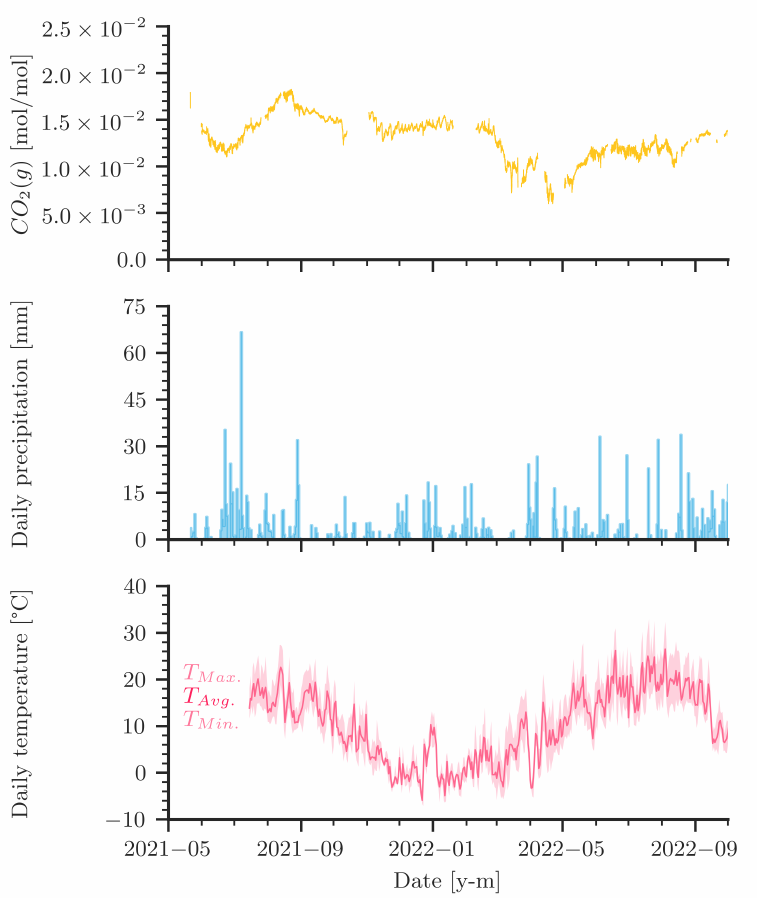
Figure 5. Measured gaseous CO 2 levels compared to precipitation and temperature during mea- surement campaign (May 2021 to October 2022). Daily precipitation data are obtained from DWD (Deutscher Wetterdienst (German Meteorological Service)) for Westerheim at 7 km distance from the cave. Temperature data are obtained from DWD for Stötten at 25 km distance from the